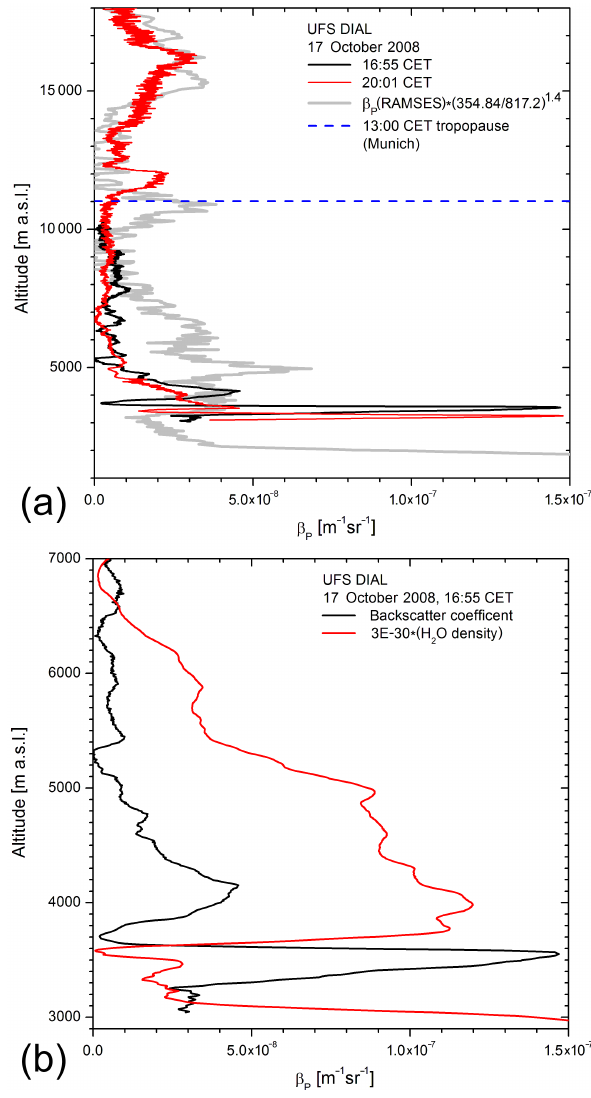
Figure 12. (a) 817.2nm aerosol backscatter coefficients for two of the measurements at UFS on 17 October 2008; the two spikes be- tween 3 and 4km are located inside the intrusion layer at these times. For comparison, a 354.84nm profile from a 3h average of RAMSES measurements around the time of the DLR overflight of Lindenberg is shown, rescaled for 817.2nm. Here, the correspond- ing aerosol peak was detected at about 5km. In the stratosphere two volcanic aerosol layers related to the Okmok and Kasatochi erup- tions are seen. (b) Vertically zoomed 16:55CET measurements at UFS: 817.2nm backscatter coefficients and water-vapour density, scaled to fit horizontally into the